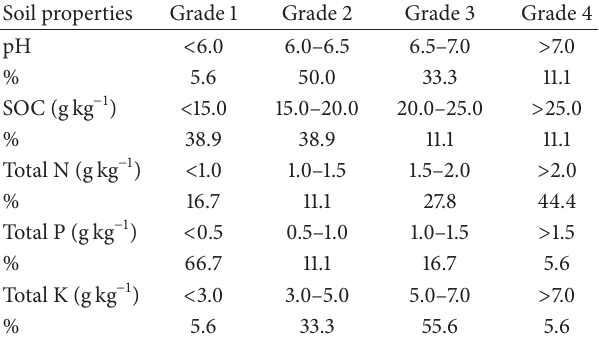
Table 3: Property statistics of the soils under in C. cathayensis forest stands sampled during a soil survey in 1984 (unpublished data, Lin’an Agricultural